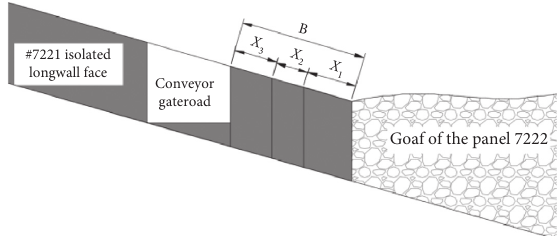
Figure 4: The calculation of coal pillar